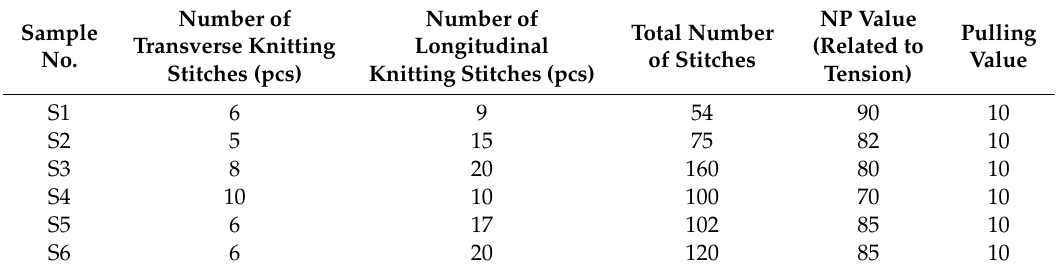
Figure 2. ( a – f ) The loop diagram, ( g – l ) simulation effects, and ( m – r ) fabric images of S1, S2, S3, S4, S5, and S6. Table 2. Knitting parameters of knitted